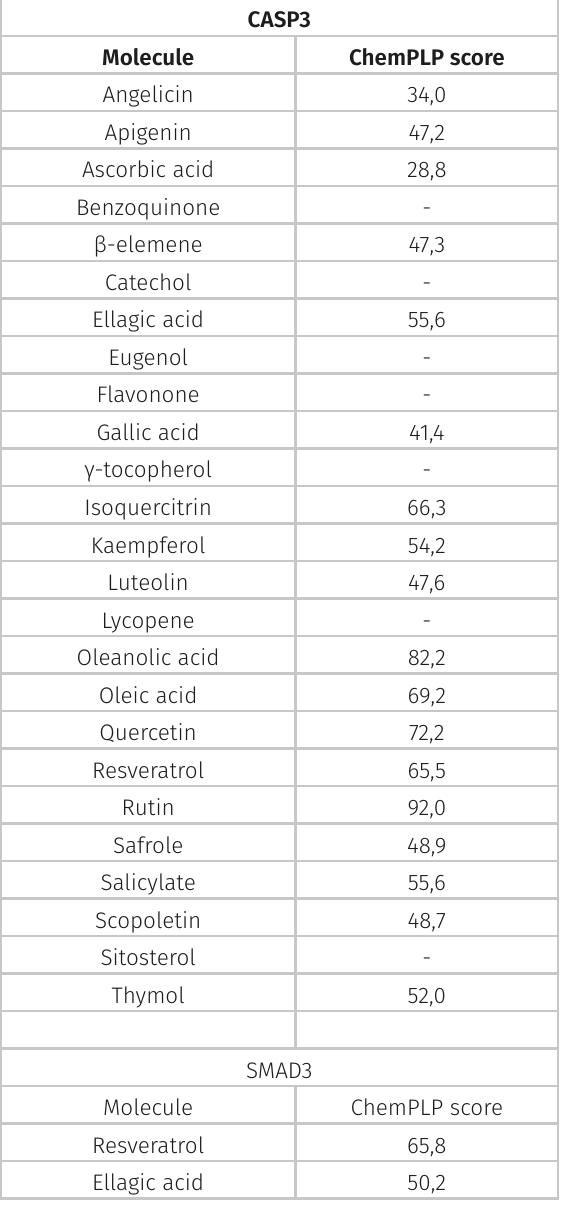
Table IV. Docking calculation for the main proteins and plant